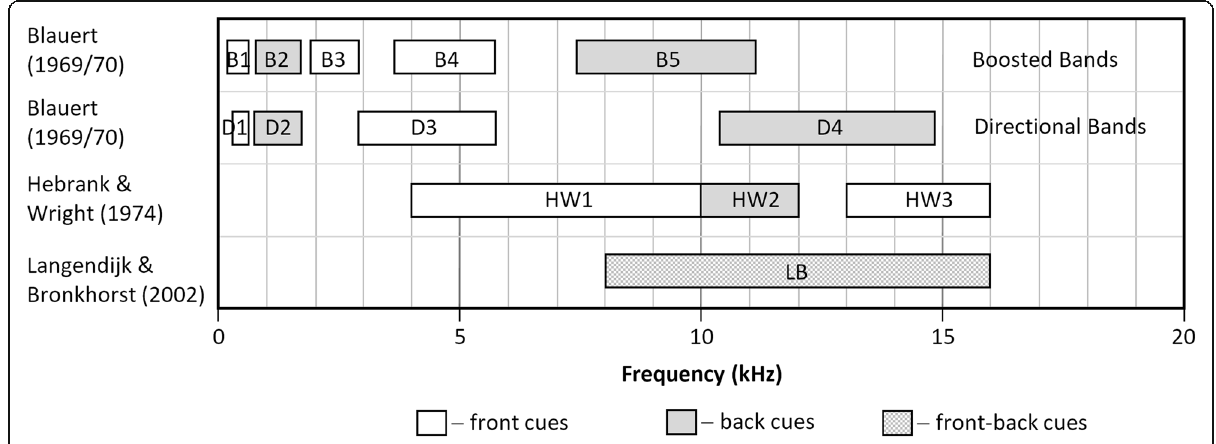
Fig. 3 Frequency bands conducive for front-back